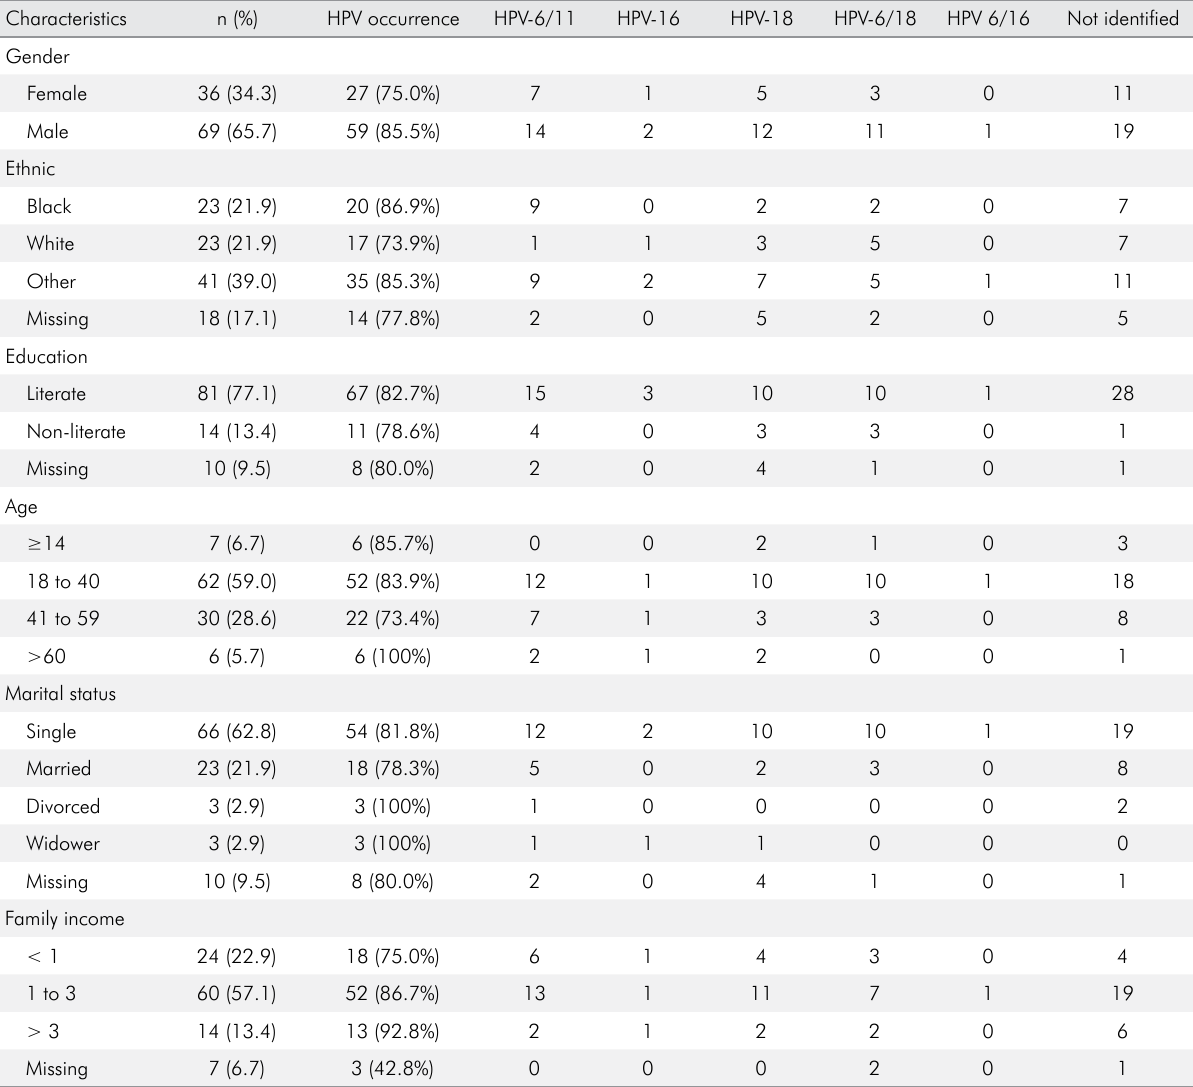
Table. Socio-demographic data and presence of HPV-DNA in the healthy oral samples analyzed in this study.